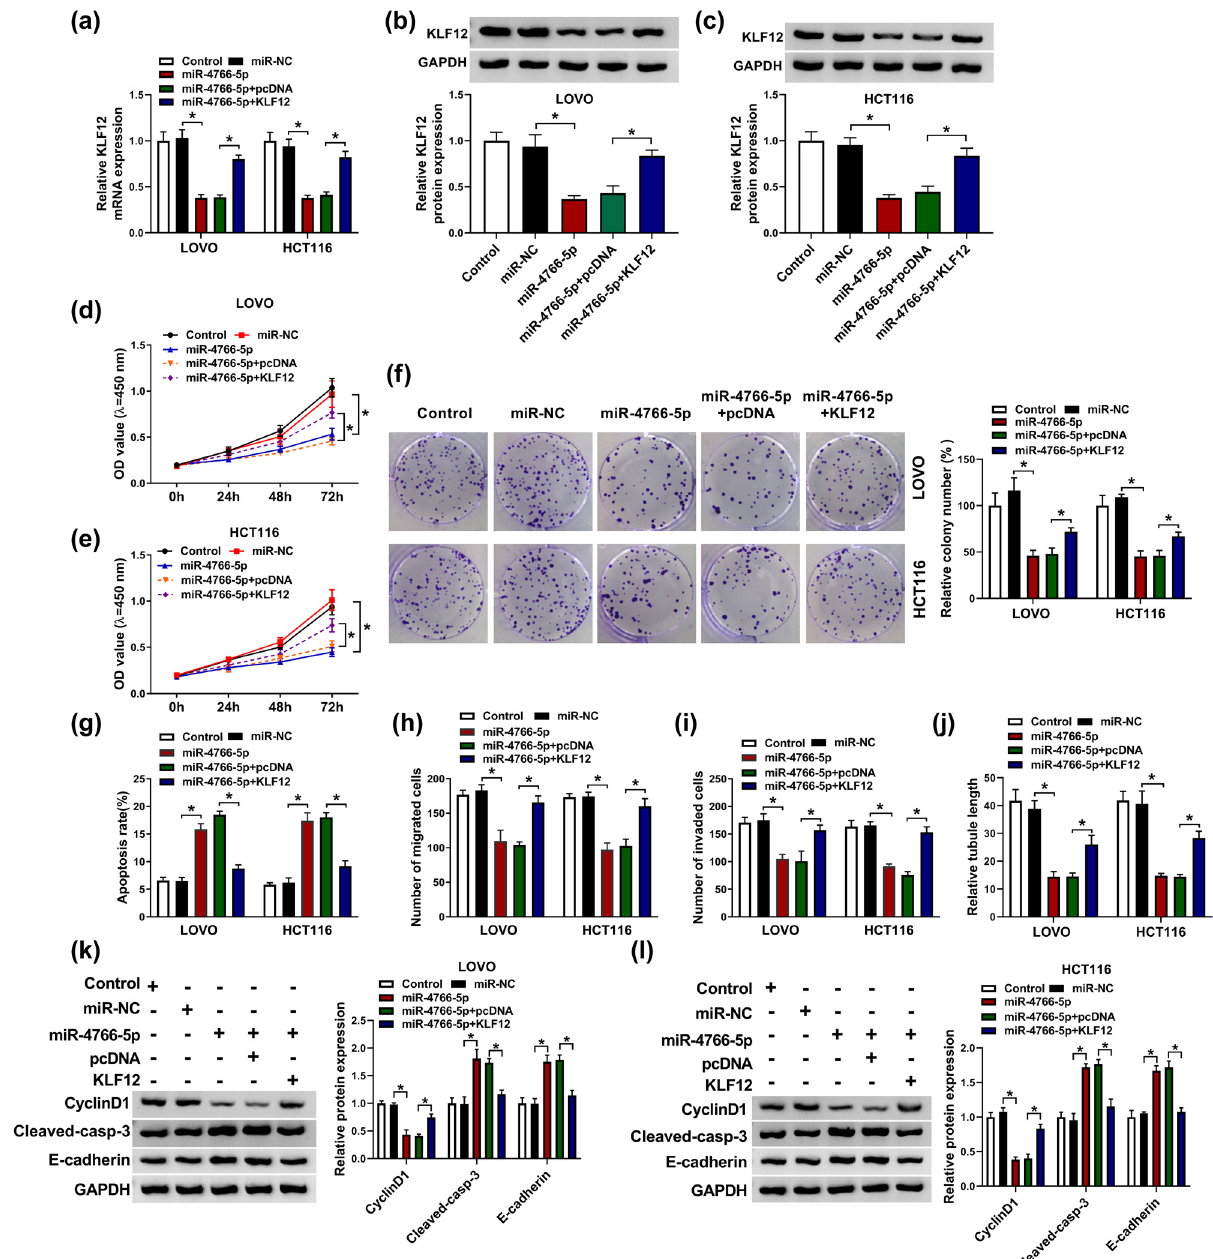
Figure 6: miR - 4766 - 5p played a suppressive role in the progression of CRC cells via downregulation of KLF12. ( a – c ) KLF12 expression after transfection with miR - 4766 - 5p, miR - 4766 - 5p + KLF12 or their controls was assayed through RT - qPCR ( a ) and WB ( b and c ) in LOVO and HCT116 cells. ( d – f ) CCK - 8 assay ( d and e ) and colony formation assay ( f ) were used for cell proliferation analysis. ( g ) Flow cytometry was used for cell apoptosis detection. ( h and i ) Cell metastatic abilities were evaluated by transwell assay for migration ( h ) and invasion ( i ) . ( j ) The examination of angiogenesis was evaluated using tube formation assay. ( k and l ) Protein determination for cyclinD1, cleaved - casp - 3, and E - cadherin was conducted using WB. * P <